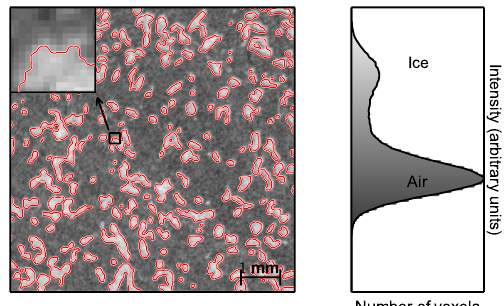
Figure 2. Grayscale image (400 2 pixels) representing the X-ray attenuation coefficient and its corresponding greyscale histogram. The 2-D slice is extracted from image G2-s1. The image exhibits two materials: air (dark grey) and ice (light grey). The contour of ice resulting from binary segmentation is plotted in red. The zoom panel (top left) was enlarged eight times to emphasise the fuzzy transition between air and